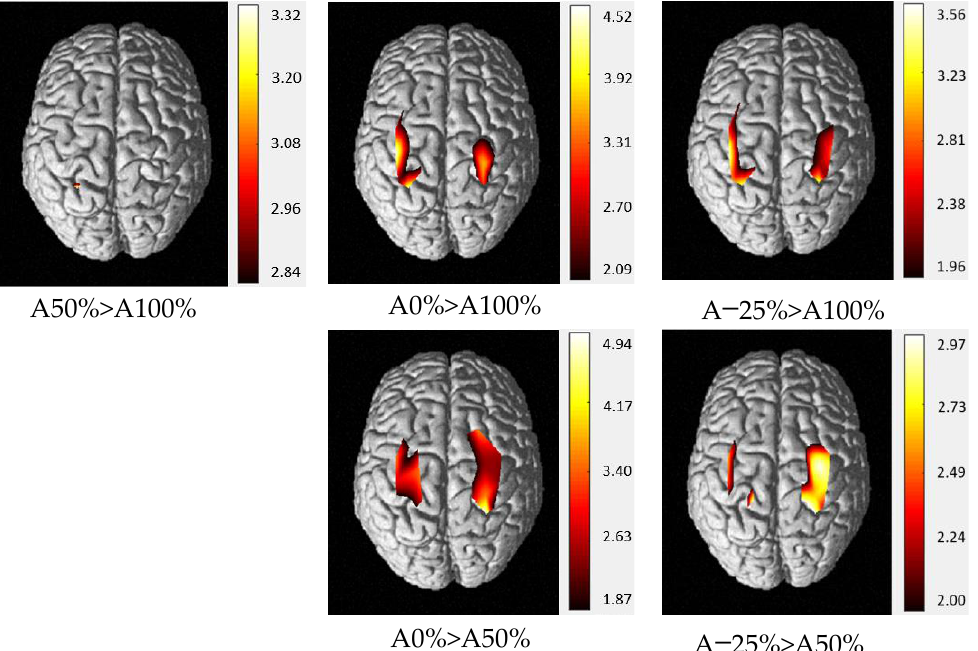
Figure 5. Two-by-two comparisons of HbO 2 levels for each level of assistance (A100%, A50%, A0%, A − 25%). The data are t values, t : statistical value of sample t-test with a significance level of p < 0.05 (Benjamini–Hochberg correction). The change from red to yellow indicates that the degree of difference is from low to high. Only statistically significant comparisons were illustrated. The data and maps were calculated and generated by NIRS-SPM.